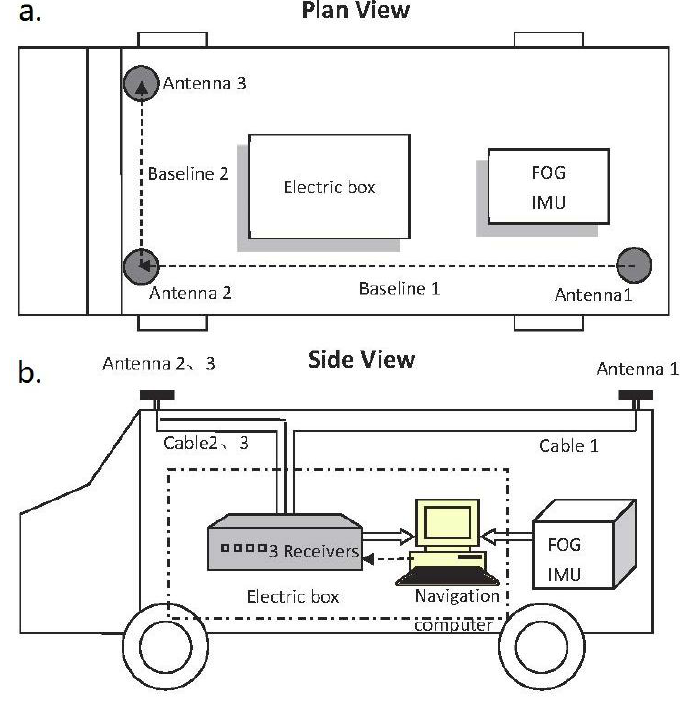
Figure 5. Testing vehicle is set up: ( a ) plan view; ( b ) side